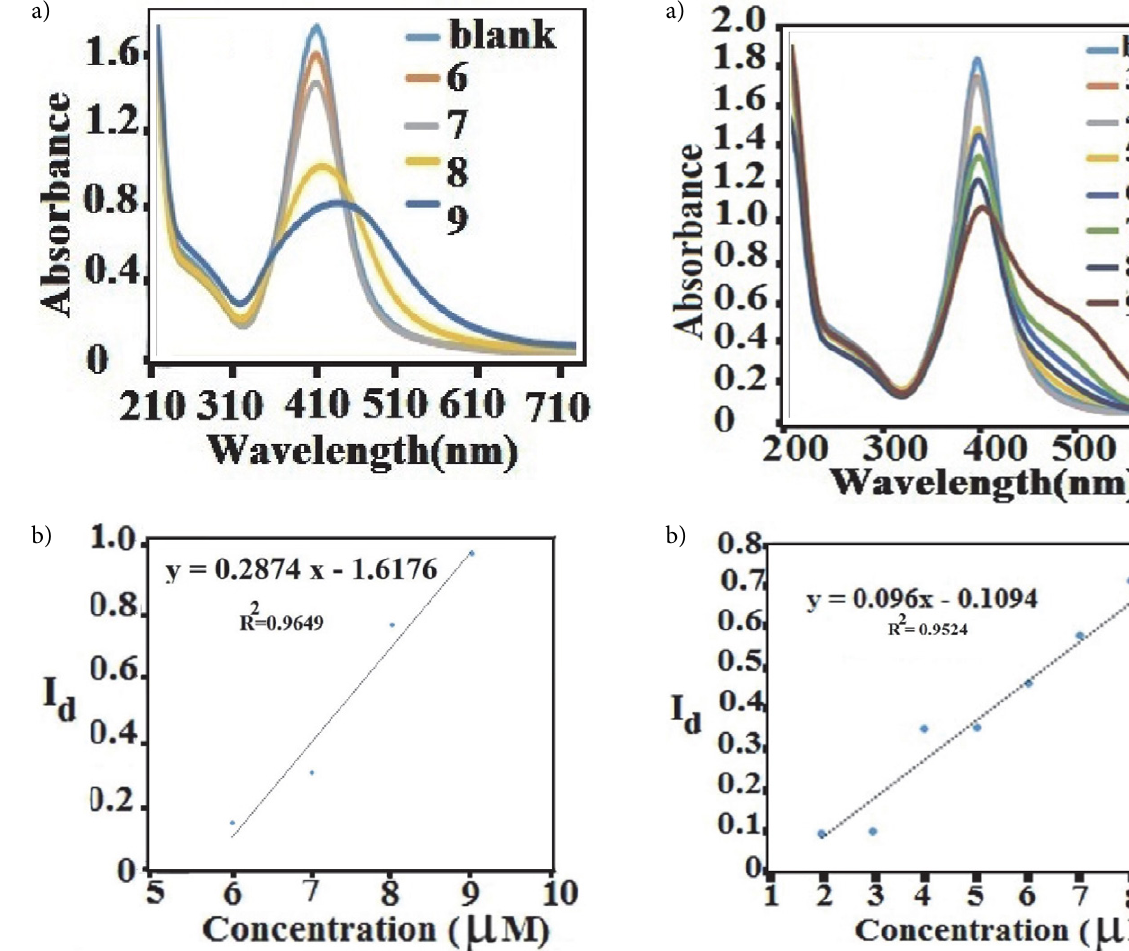
Figure 8. (a) absorption spectral changes observed for SDS-CD-Ag- NPs after the addition of Cr 2+ ions at a concentration range from 3 µM to 9.0 µM and (b). The plot of changes in the value of the ab- sorption intensity at the maximum wavelength (λ400) of SDS-CD- AgNPs against Cr 2+ ions concentration from 3.0 µM to 9.0 µM